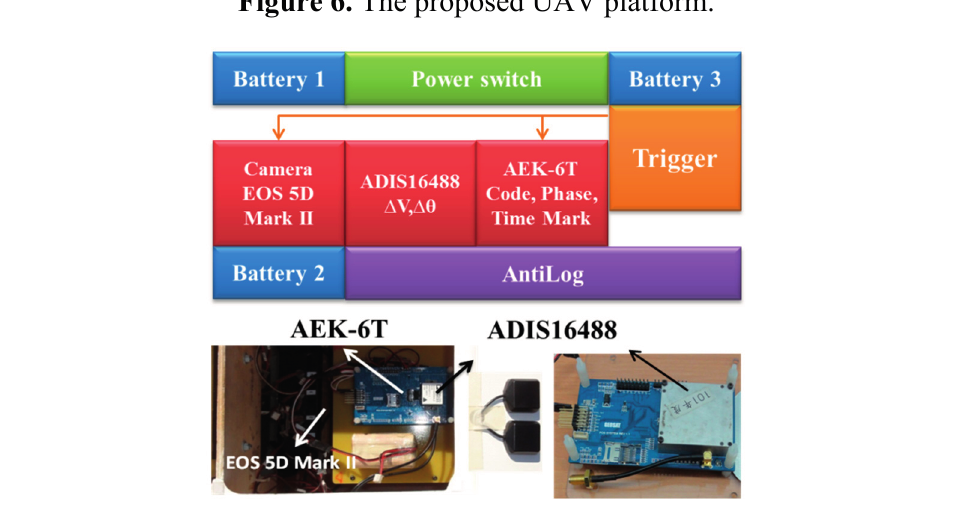
Figure 7. The configuration of DG